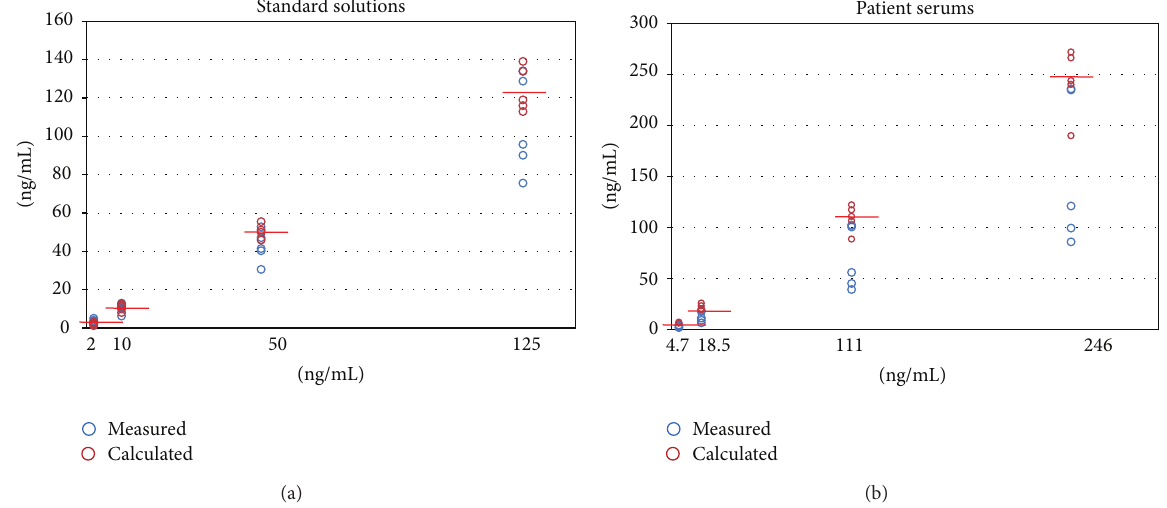
Figure 3: For each concentration of TgAb, the calculated Tg concentrations were more similar to expected Tg concentrations than measured Tg concentrations in samples from both standard solution and patients’ serum.